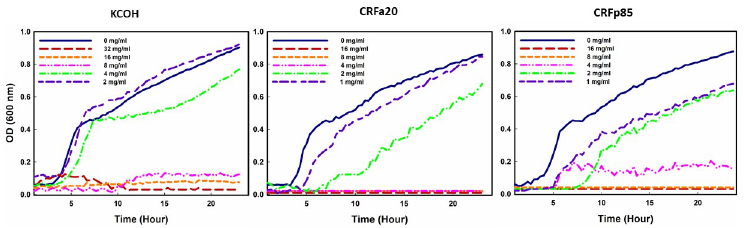
Fig 2. Concentration-dependent growth inhibition of Salmonella Enteritidis ABBSB1004-1 in CAMHB containing ethanolic extract from cranberry pomaces (KCOH) and two of it sub-fractions anthocyanins (CRFa20) and non-anthocyanin polyphenols/flavonols